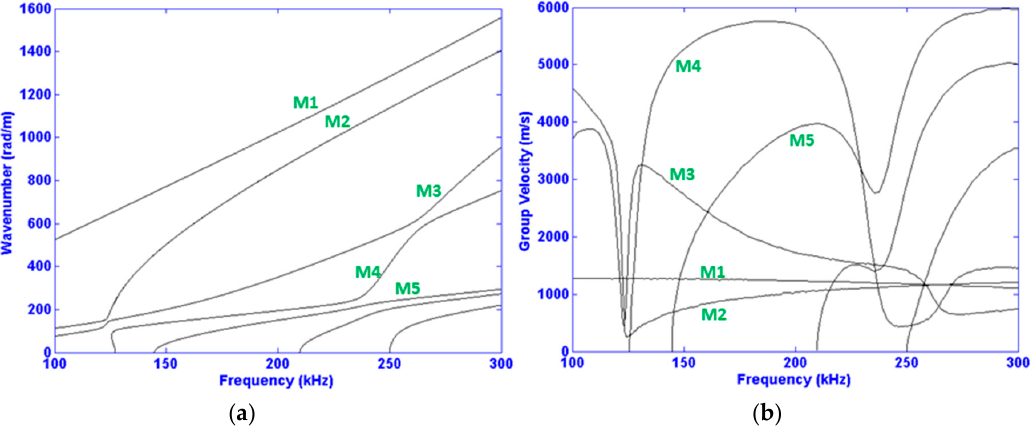
Figure 4. Wavenumber ( a ) and group velocity ( b ) dispersion curves determined along the direction of propagation ( x ) for the two-layer structure shown in Figure 3. M i denotes modes i with i = 1, 2, 3, 4 and 5.